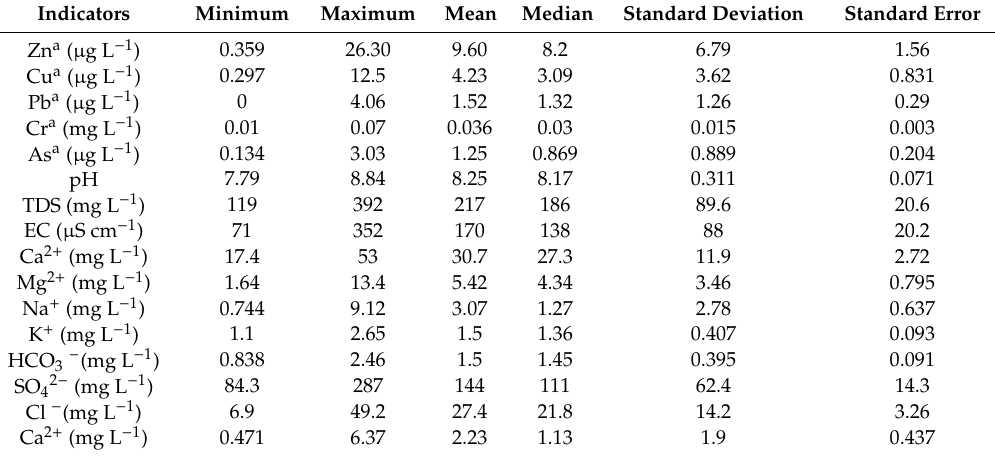
Table 3. Environmental indicators of river water in the Issyk − Kul Basin during the period with high river flow (H, n = 19